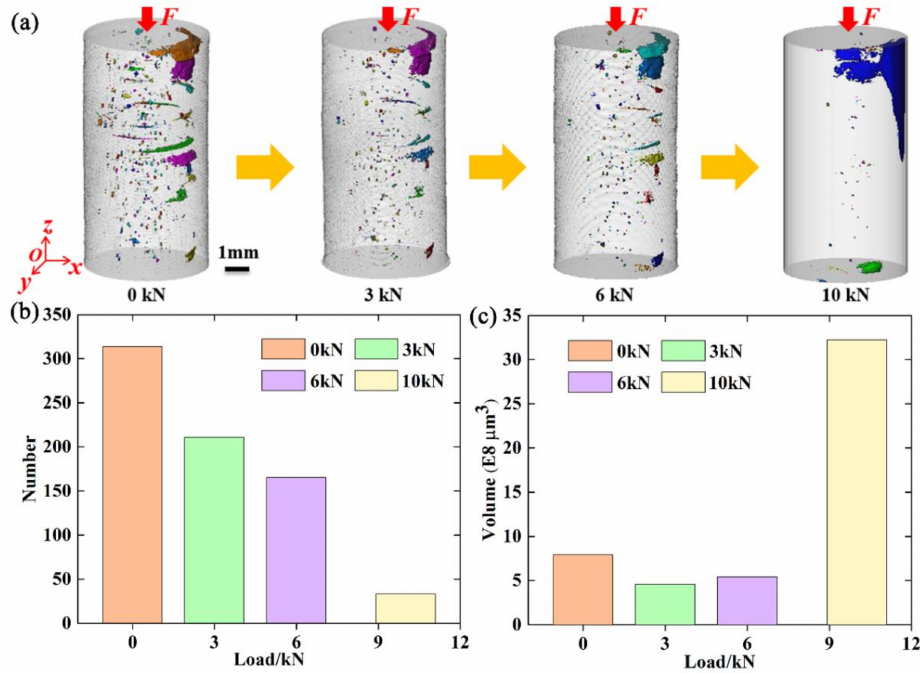
Figure 5. ( a – c ): Three-dimensional volume rendering, number, and volume, respectively, of total flaws at different compressive